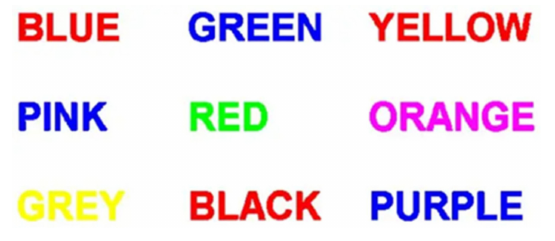
Figure 5. Stroop